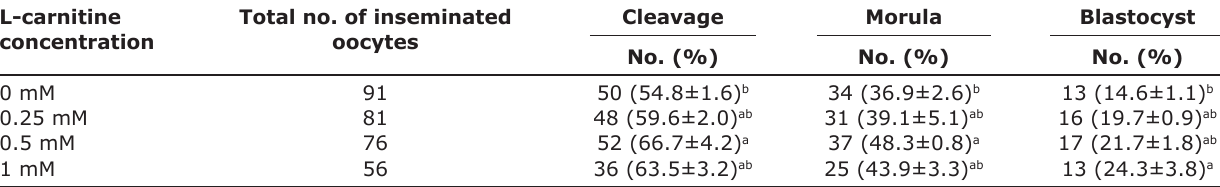
Table-1: Developmental competence of buffalo oocytes after culture supplementation with different concentrations of L-carnitine (Mean±SE). L-carnitine